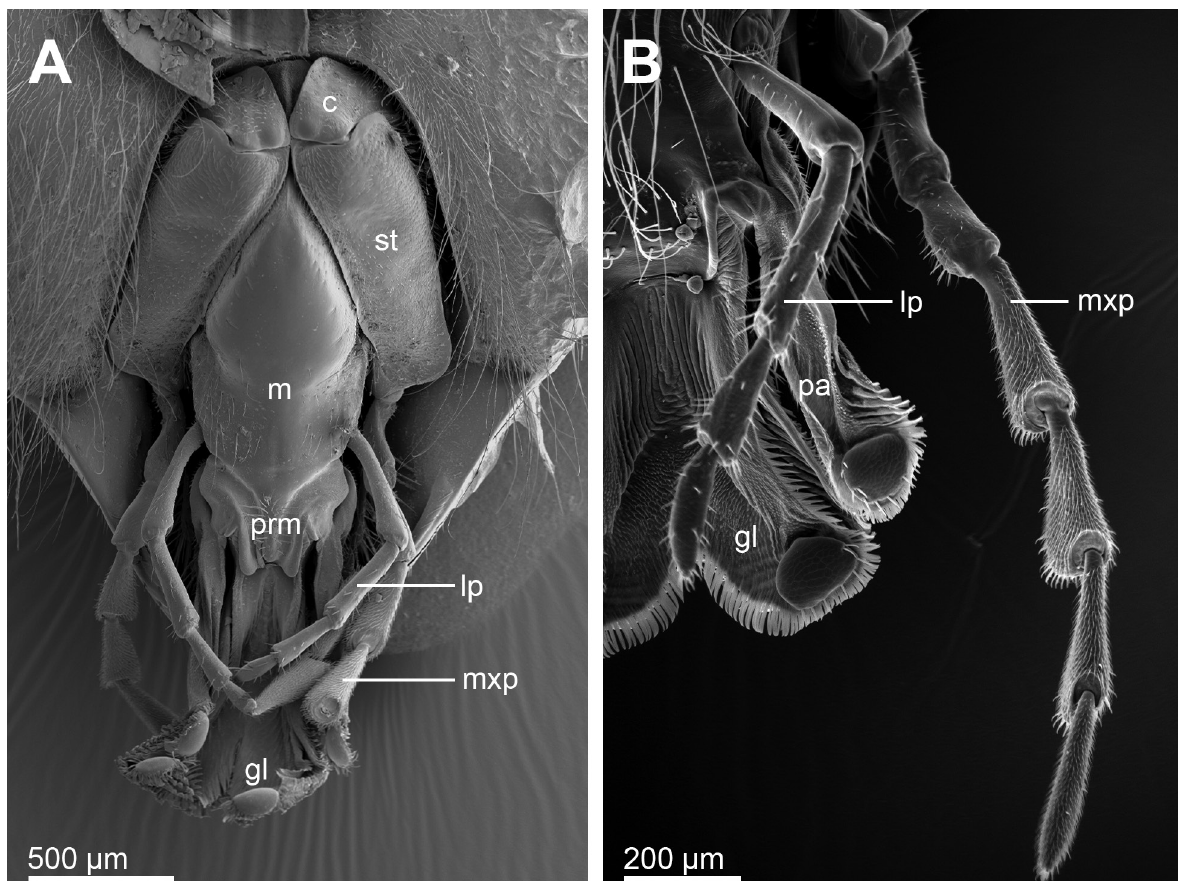
Figure 4. Labio-maxillary complex (SEM), head in posterior view. A . Maxilla and labium in resting position, ligula ( gl – glossa and paraglossa) folded, female worker; c – cardo, lp – labial palpus, m – mentum, mxp – maxillary palpus, prm – prementum, st – stipes. B. Extended ligula, labial palpus ( lp) and maxillary palpus ( mxp ), male; gl – glossa, pa –